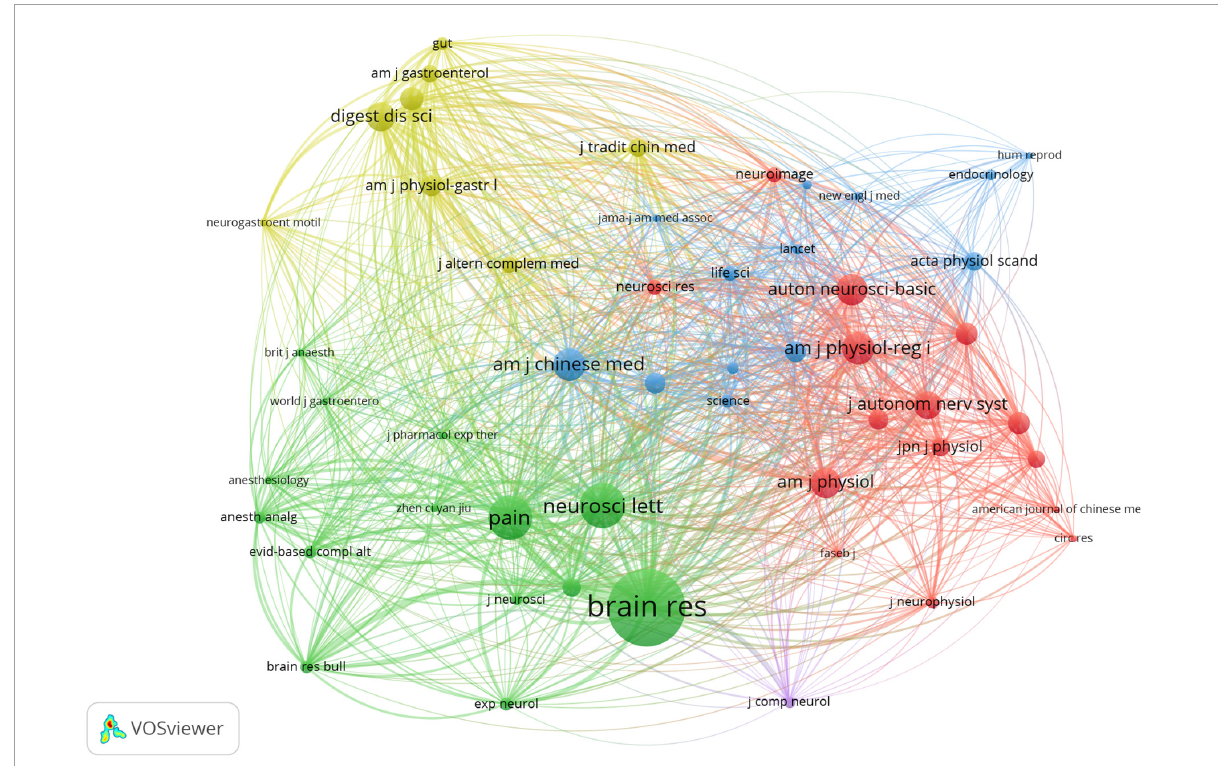
FIGURE3 Network map of journals that were co-cited in more than 20 publications.